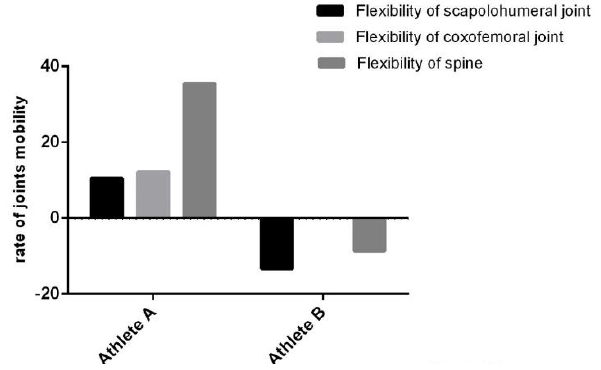
Figure 12. Comparison between the percentage mean variations of two athletes: Athlete A has completed the training, while Athlete B has totally interrupted the workout for one and a half months.